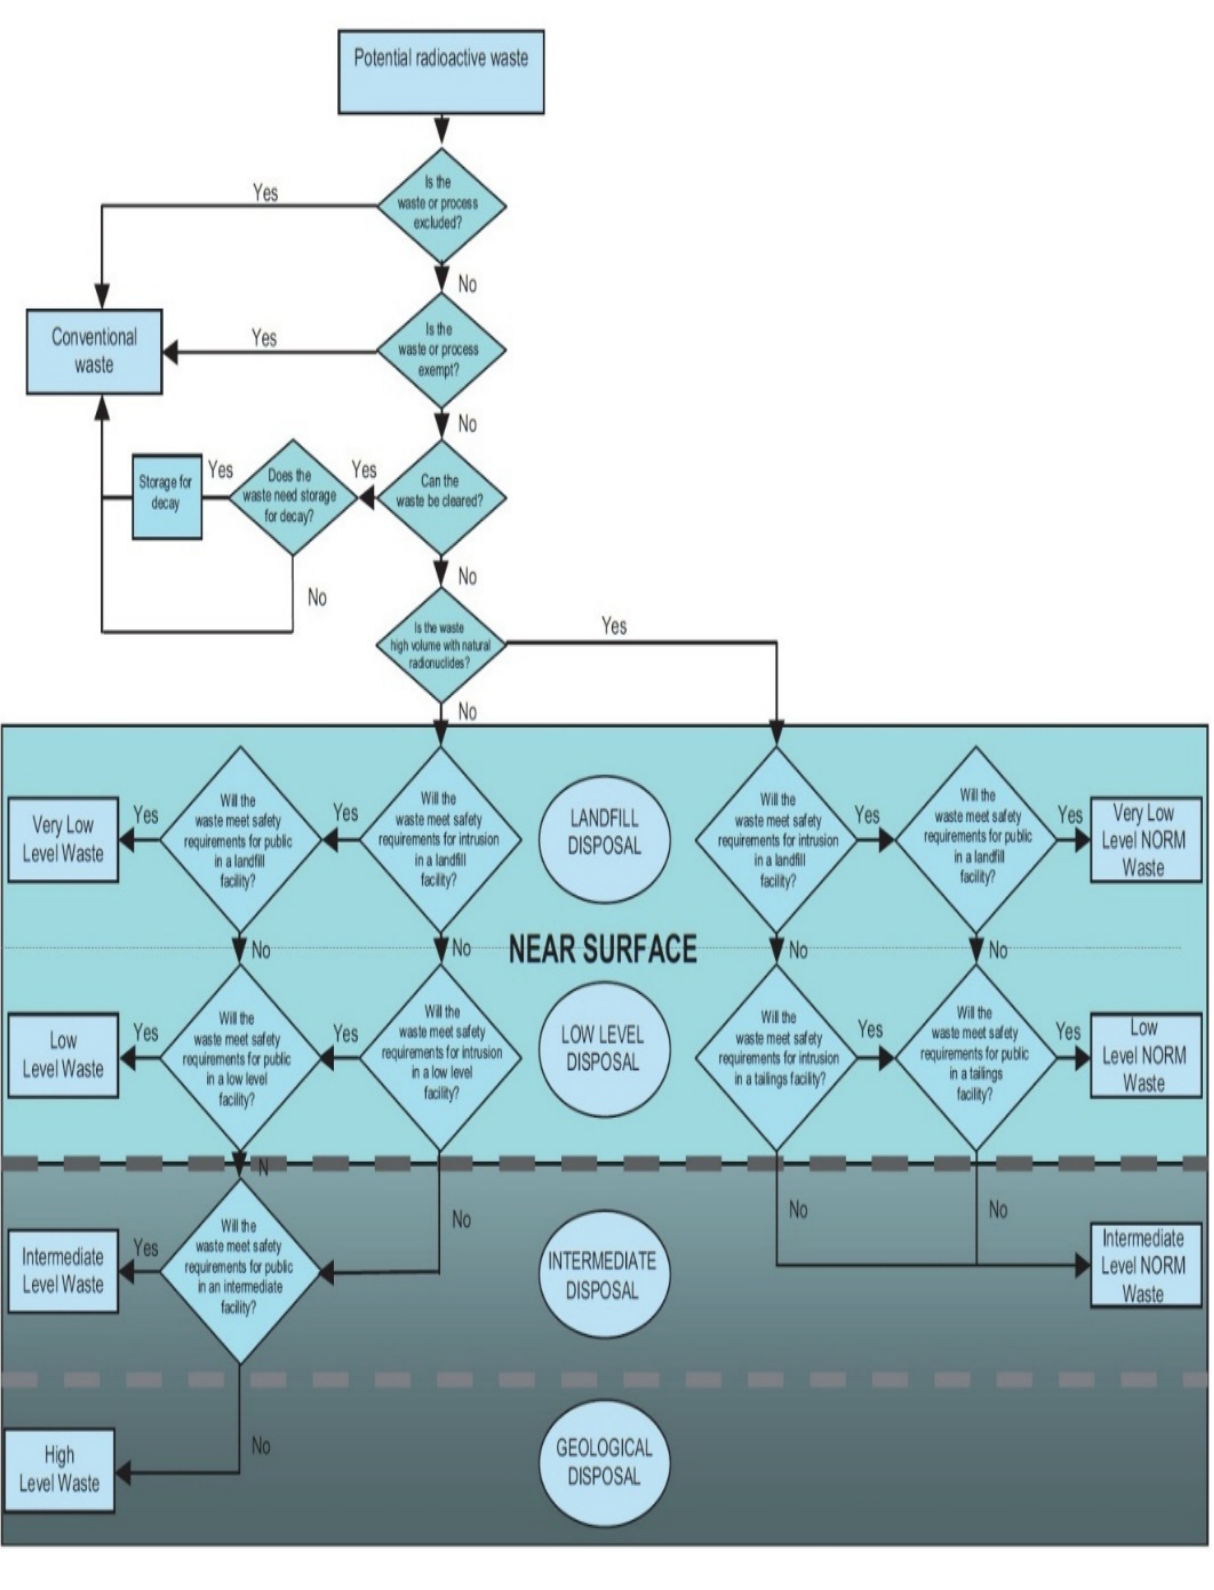
Figure 3. Logic diagram illustrating the use of the IAEA classification scheme to assist in determin- ing disposal options. Reproduced with permission of the IAEA from [16].